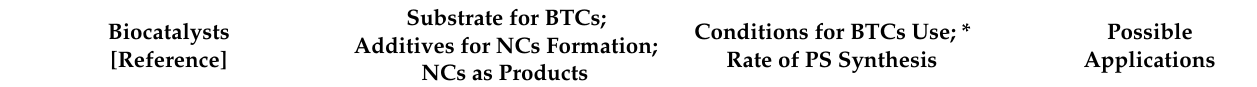
Table 3. BTCs for obtaining nanocomposites in the process of PS